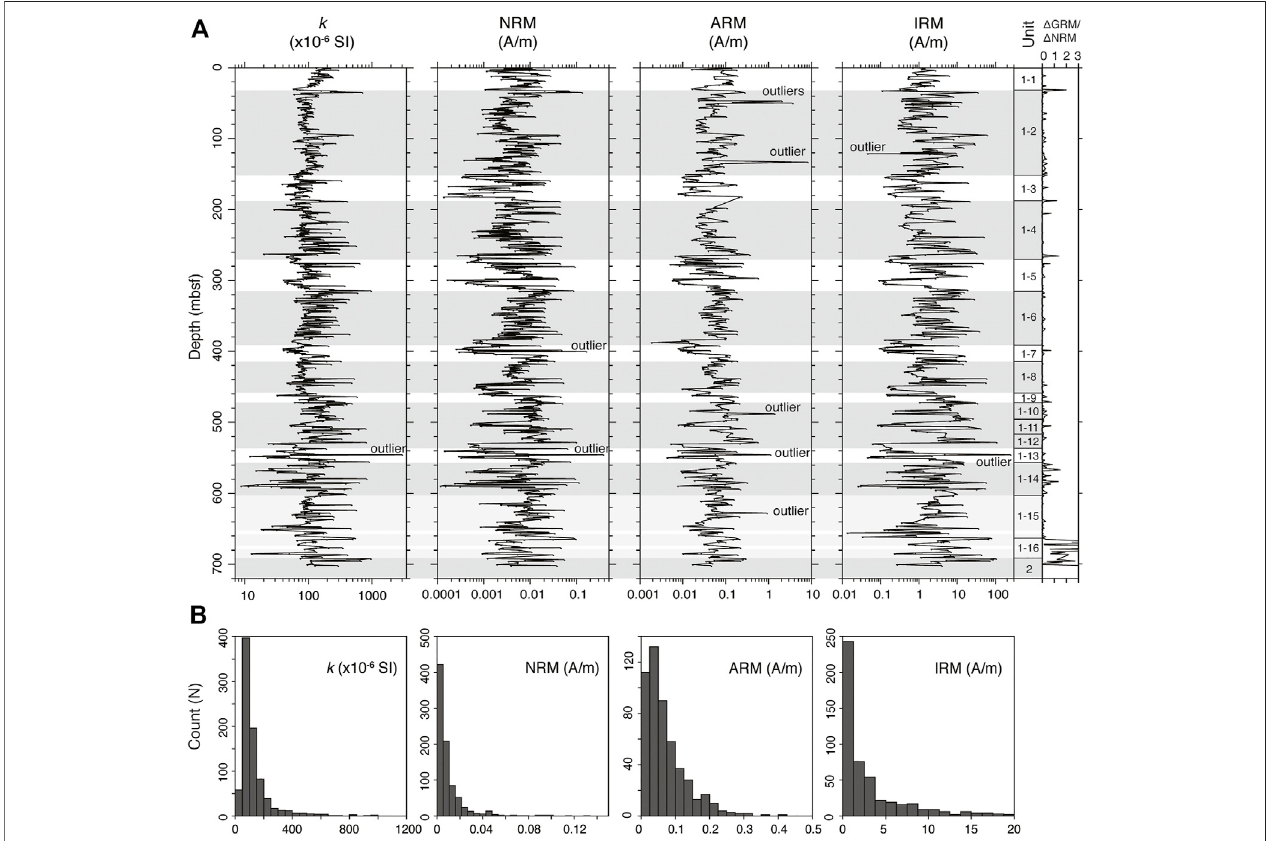
FIGURE 5 | (A) Downhole variation of (from left to right) magnetic susceptibility (k), NRM, AIR, and IRM. Values are in logarithmic scale to better appreciate the fl uctuation of the four parameters. Outliers showing anomalously high values are indicated. Lithostratigraphic column is shown on the right, together with the Δ GRM/ Δ NRM values indicating the concentration of greigite. White and gray shaded areas correspond to marine and isolated intervals, respectively. (B) Frequency distribution of the four magnetic parameters in (a). Note that the tails of the ARM and IRM plots have been cut for visual reasons.